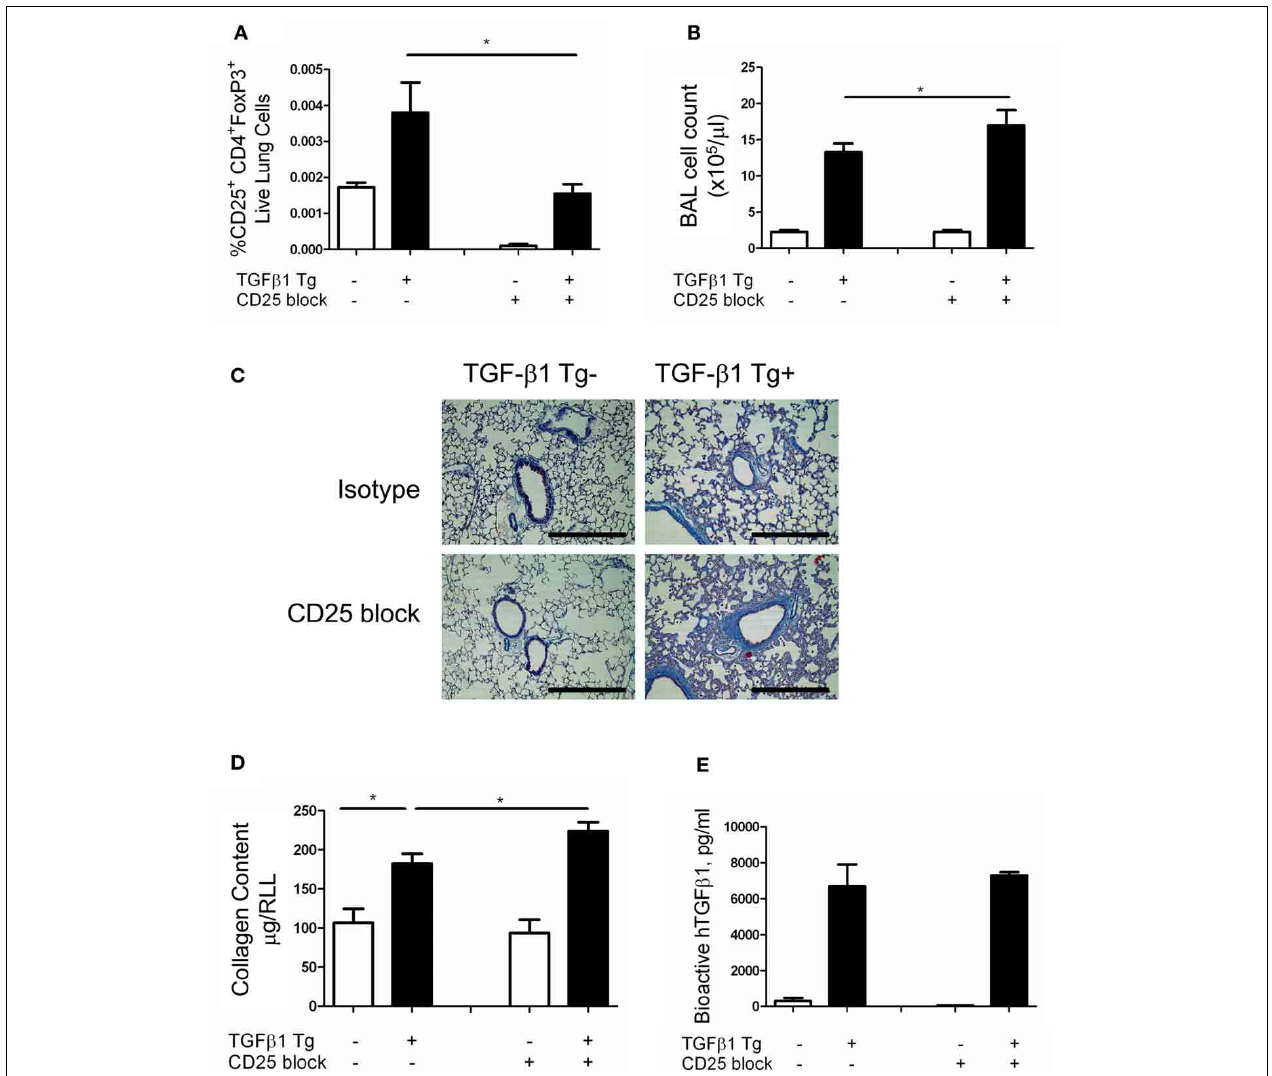
FIGURE 2 | Depletion of Tregs exacerbates TGF- β 1 induced lung fibrosis. TGF- β 1 Tg + and Tg − mice were administered doxycycline for 14 days during which they were injected i.p. with anti-CD25 antibody on days 4, 7, and 10. All mice were sacrificed on day 14, BAL was performed, and lungs were processed for flow cytometry, Sircol assay, and histology as described in the Methods. (A) Percentage of live lung cells that are CD25 + /CD4 + /FoxP3 + as determined by flow cytometry performed on combined right upper and